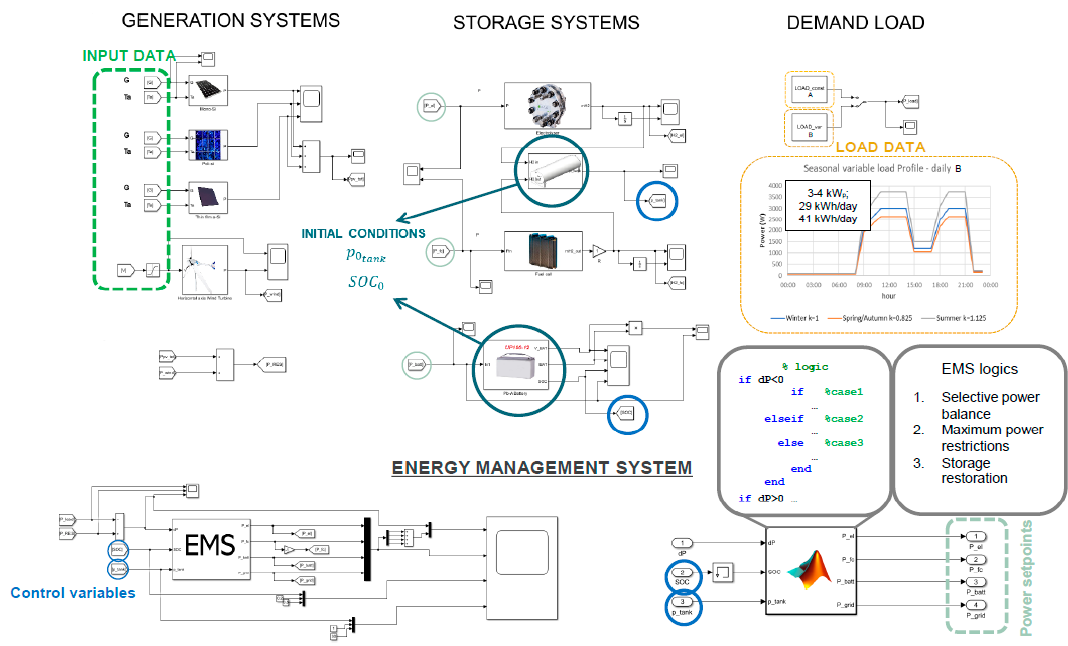
Figure 16. Simulink global model interface.